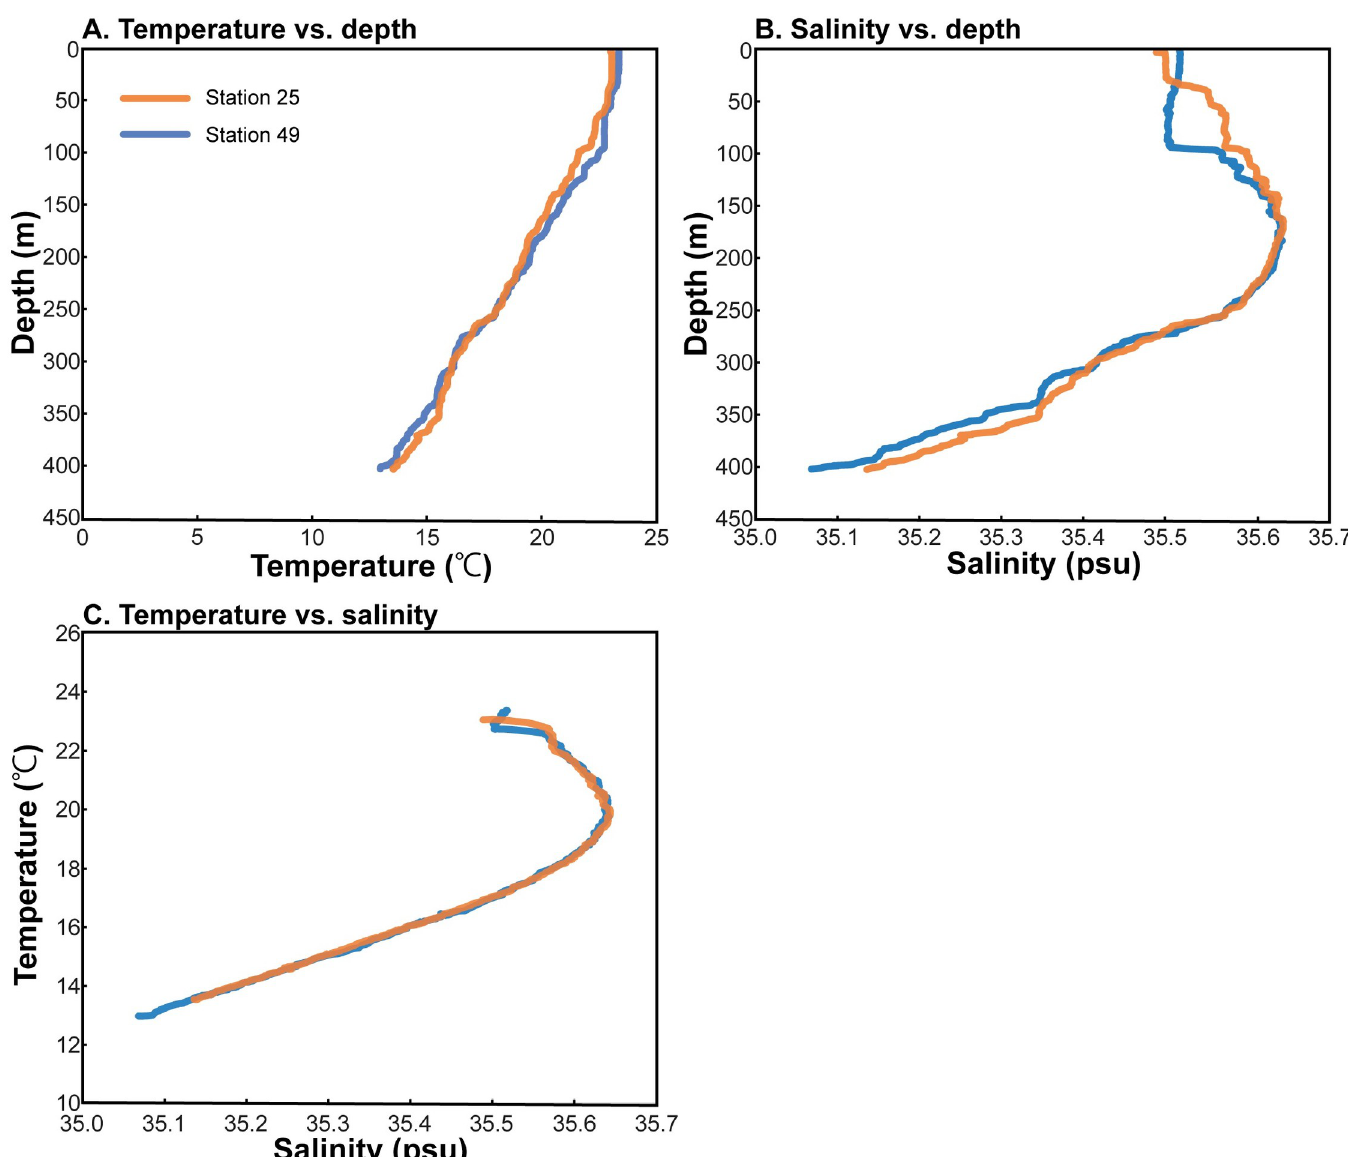
Fig 3. Hydrography. Temperature versus depth (A); Salinity versus depth (B); TS diagram (C).